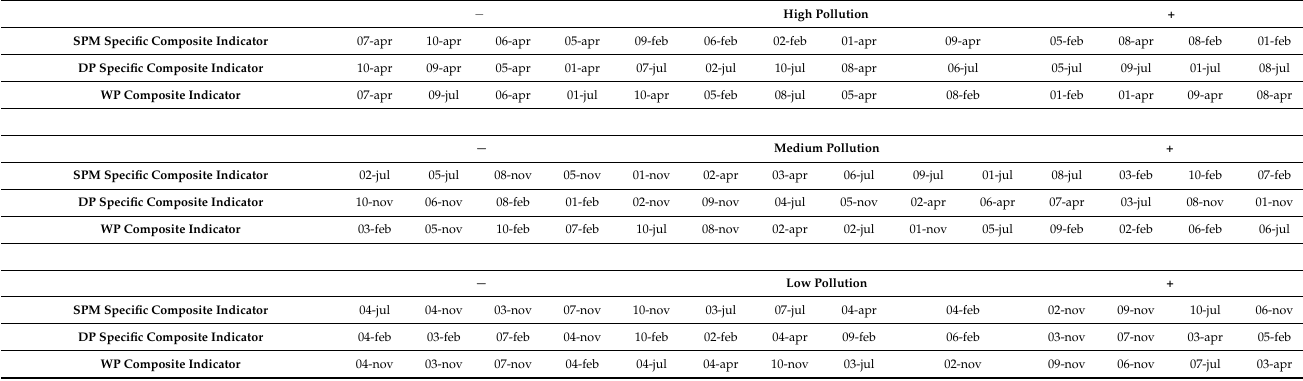
Table 3. Rankings based on SCIs and WP-CI according to these thresholds, (1): Normalized score > 0:60, (2): Normalized score > 0:30 and < 0:60, (3): Normalized score < 0:30.